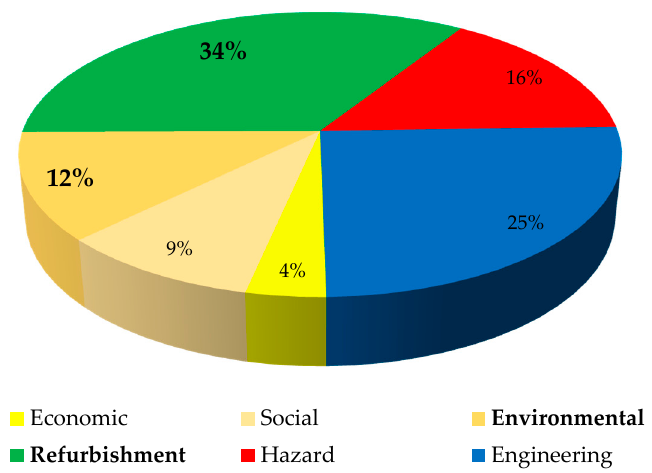
Figure 3. Distribution of the documents by field of publication i.e., content characteristics.